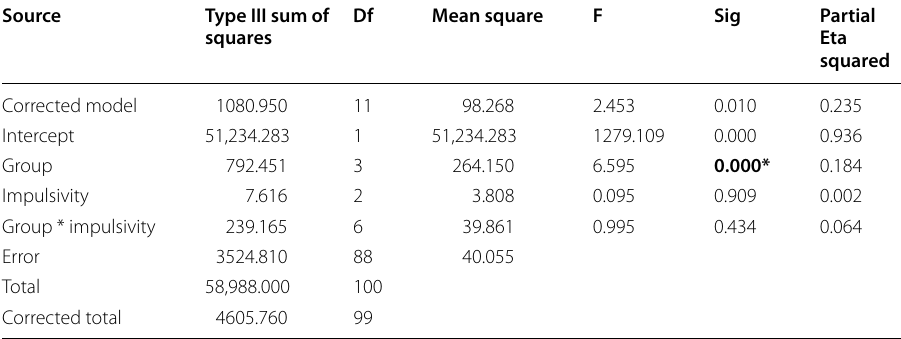
Table 6 Tests of between-subjects effects